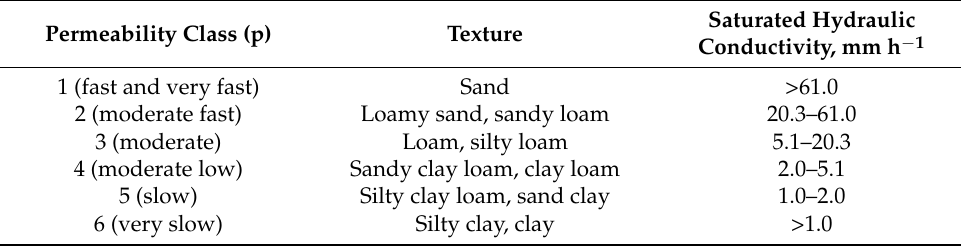
Table 2. Classes of soil structure derived from the European Soil Database.